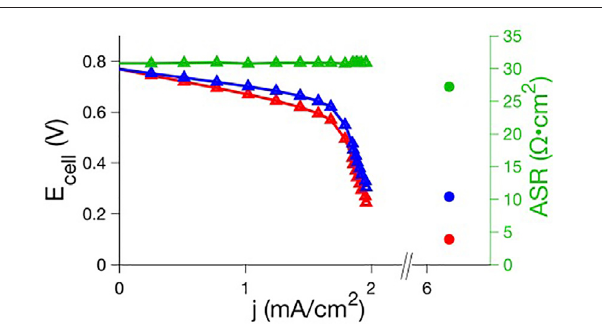
FIGURE4| Raw(red)andiR-compensated(blue)polarizationcurveand ASR (green) data for ferrocene posolyte-menadione negolyte polysorbate 20 microemulsion RFBs. A full polarization curve for a preliminary system (triangles; 89.9% 0.5 m KNO 3 aq, 7.5% polysorbate 20, 1.6% 1- butanol,1.0%toluene;carbonfeltelectrodeswith99%compression;4.9 mM ferrocene, 2.5 mM menadione) is compared to the maximum current density and ASR for an optimized system (circles; 20% 1.5 m KNO 3 aq, 47% polysorbate 20, 10% 1-butanol, 23% toluene; carbon fi ber electrodes with 30% expansion; 160 mM ferrocene, 80 mM